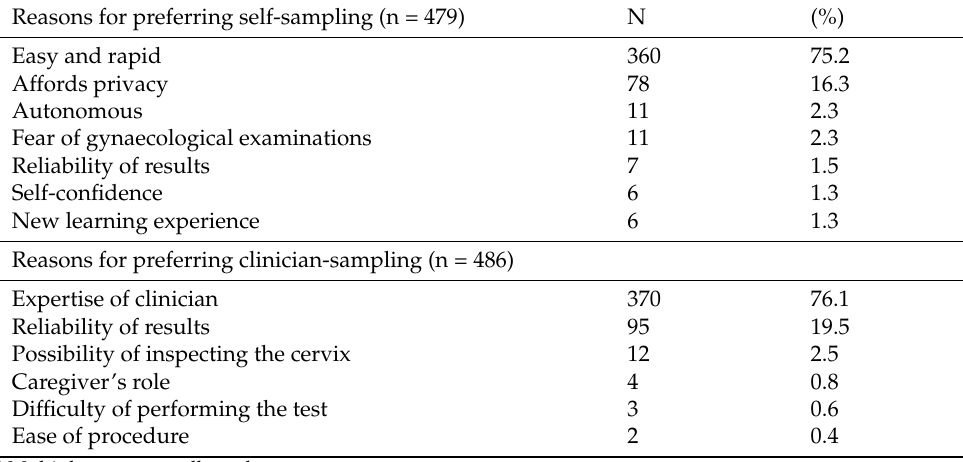
Table 4. Reasons for preferring HPV self-sampling or clinician-sampling